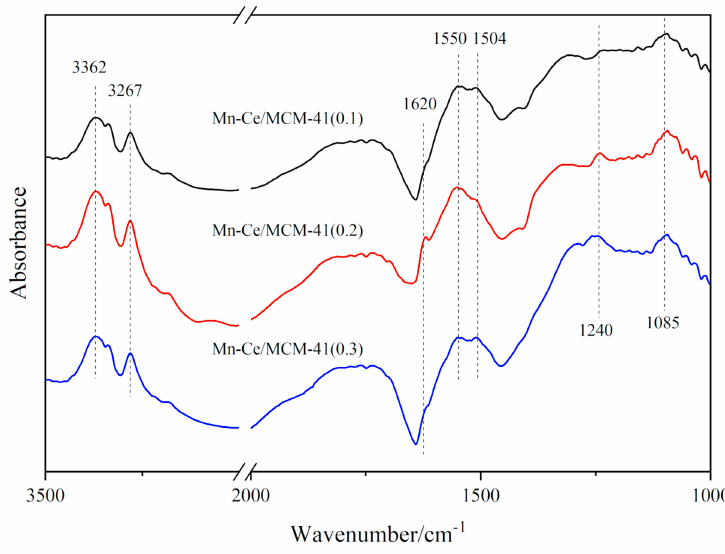
Figure 14. In situ DRIFTS spectra of NH 3 adsorption over catalytic materials with di ff erent ratio of template at 275 ◦